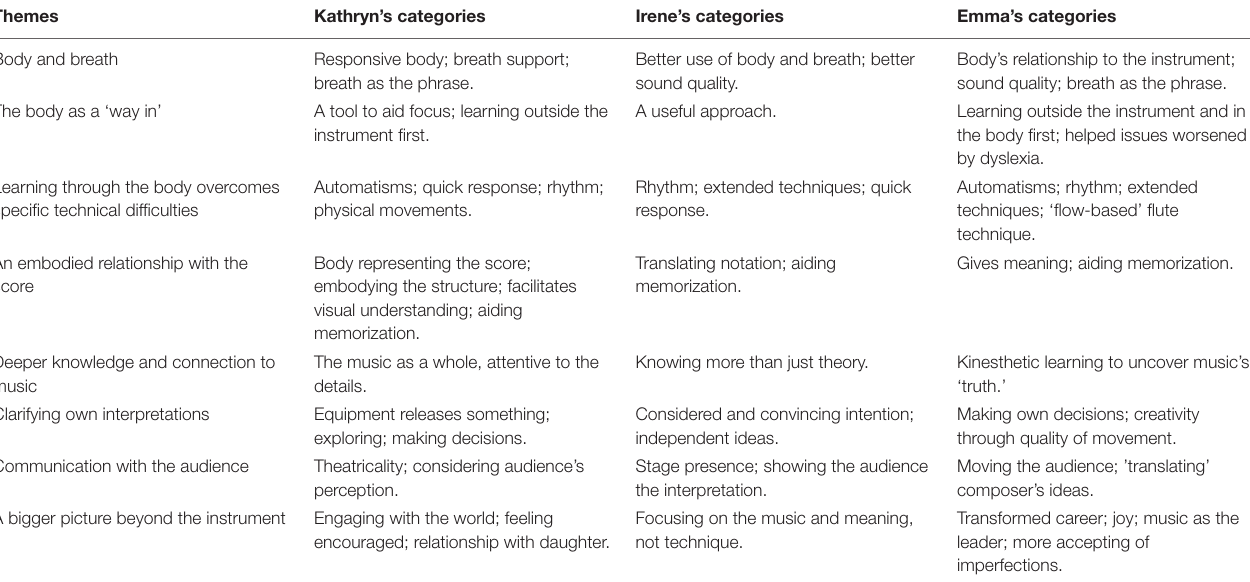
TABLE 1 | The eight super-ordinate themes alongside the corresponding categories for each